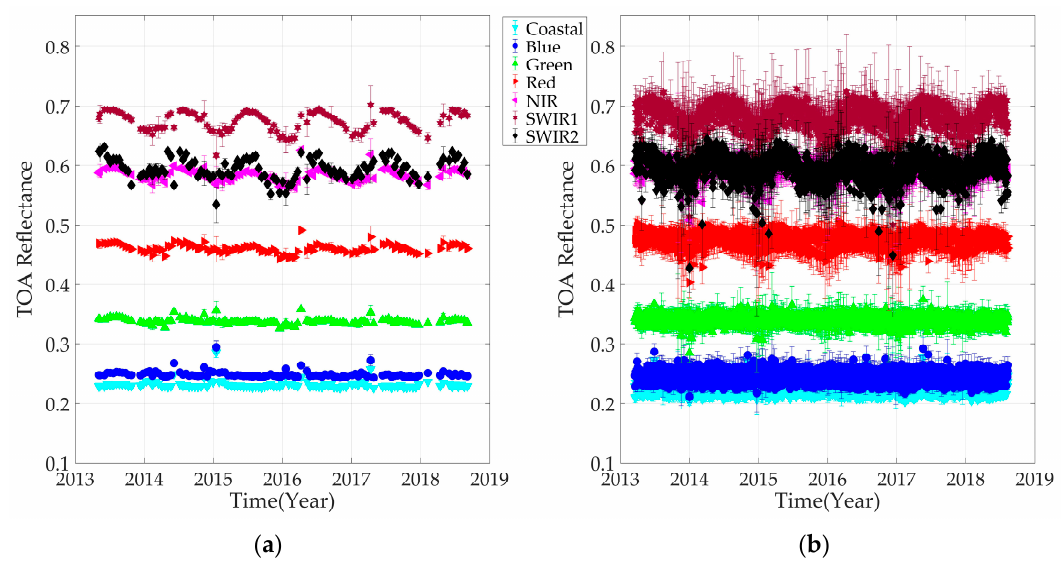
Figure 6. Comparison between traditional PICS (Libya 4) (a) and Cluster 13 (b) behavior. Figures (a) and (b) show the trending of Libya 4 and Cluster 13, as a function of time since launch to August 2018, using Landsat 8 OLI.